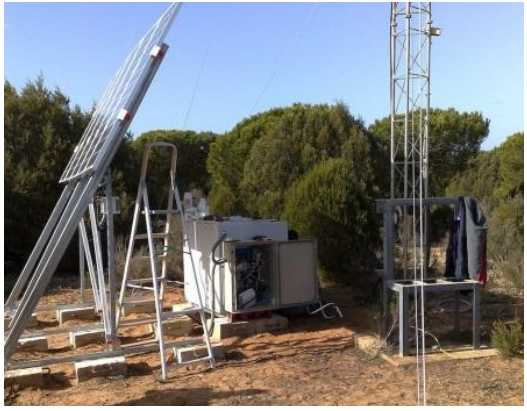
Figure 2. National Park of